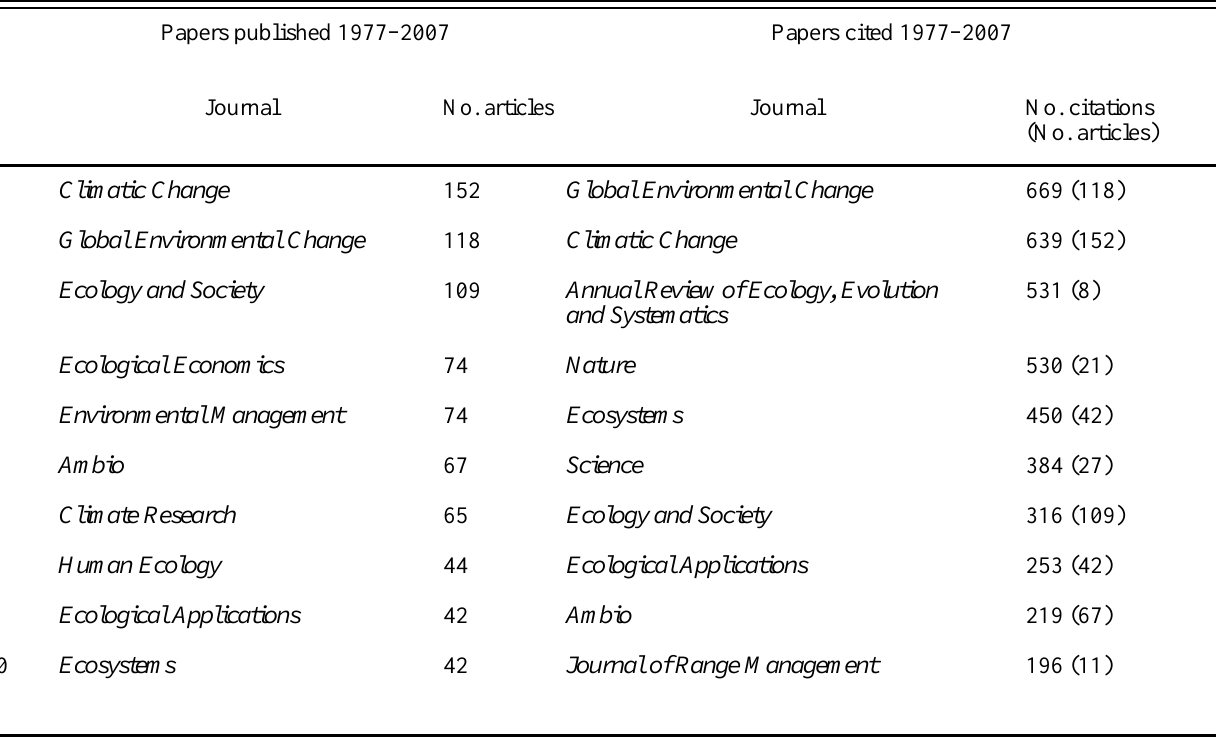
Table 1 . The top 10 journals with the largest number of papers (left) and the highest number of citations (right) in the knowledge domains “resilience,” “adaptation,” and “vulnerability” in the database for the period 1977–2007 (from Janssen